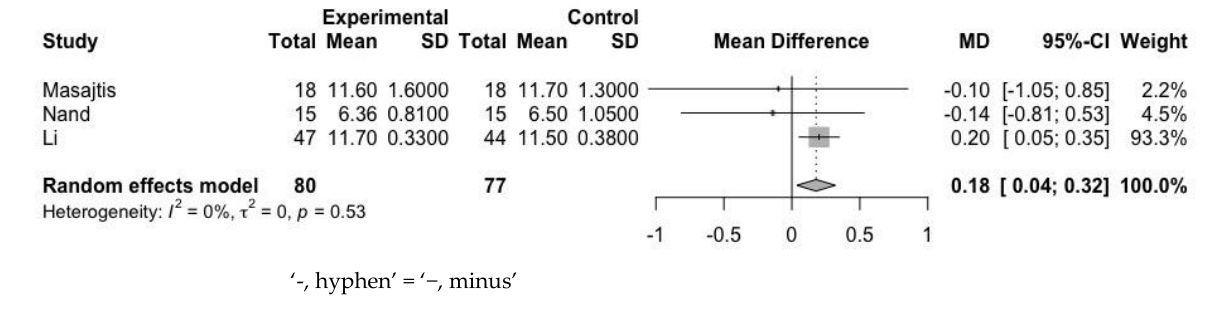
Figure 5. Mean difference of Hb between experimental group and control group at baseline.